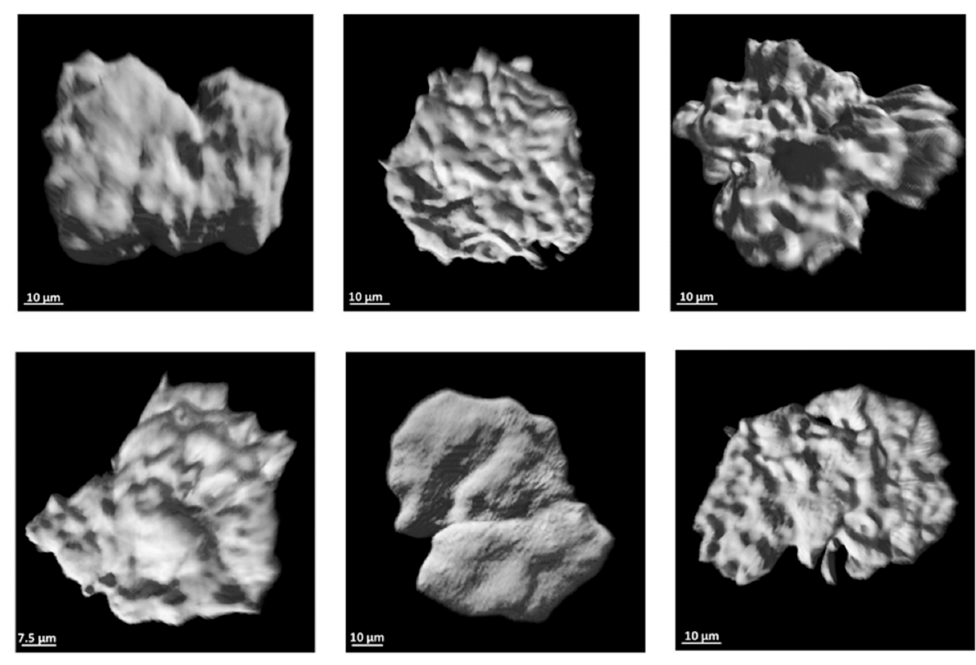
Figure 3. Reconstructed surface of renal glomeruli. Representative images of the surface glomeruli. Each glomerulus was obtained from one of the six left kidneys studied.